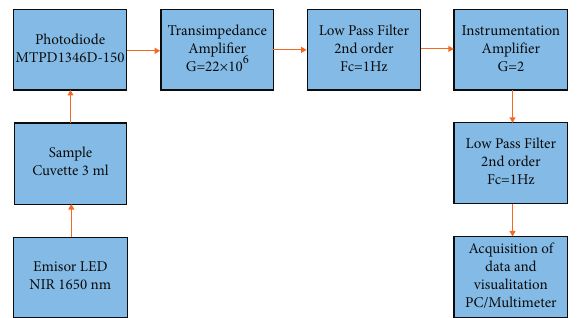
Figure 2: System block diagram. Table 1: Concentrations used for preparing samples of glucose